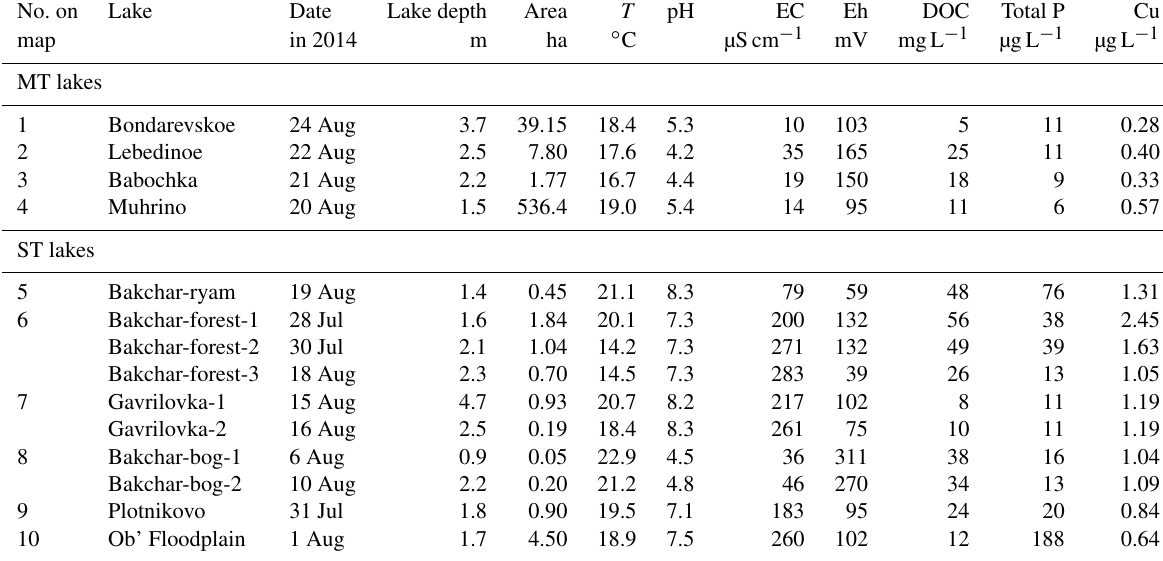
Table 1. Basic characteristics of study lakes (mean values of three measured values – bottom, middle, surface). No.